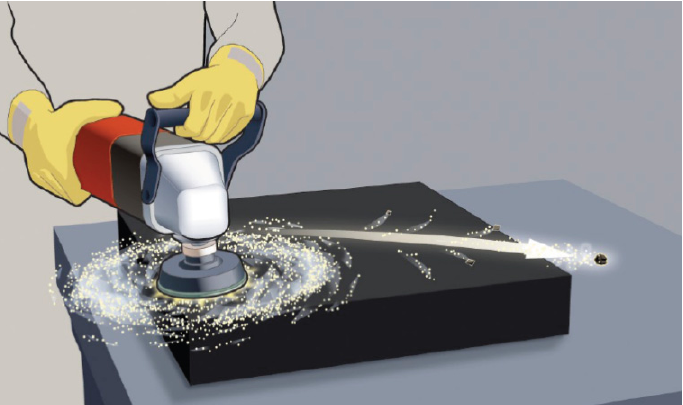
Figure 1. Schematic representation of particle dispersion when polishing granite (Goyer et al. (2010) [7]).